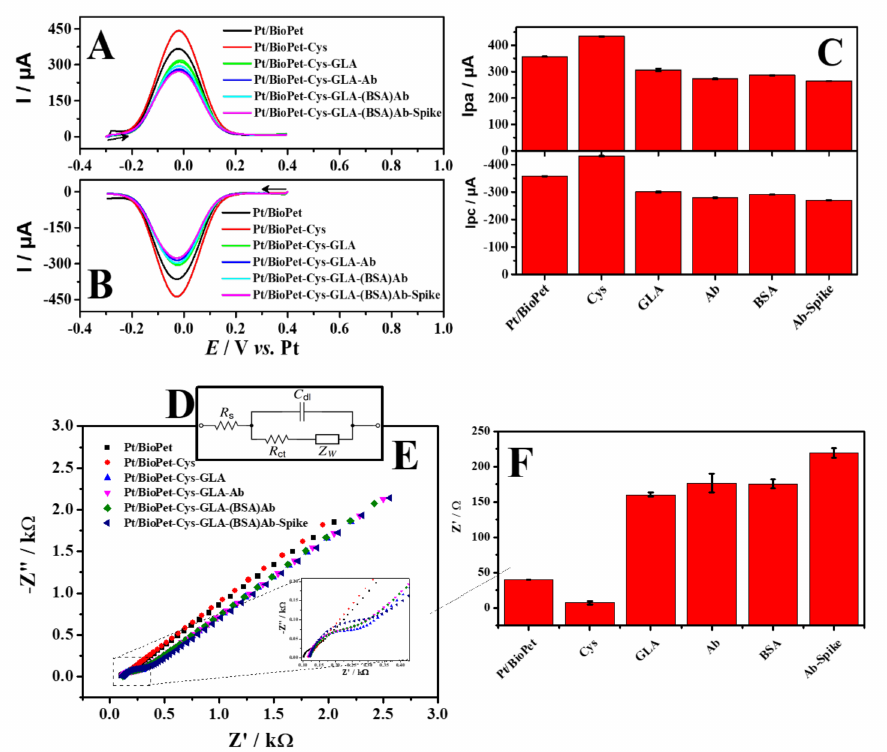
Figure 4. SWV voltammograms at ( A ) direct and ( B ) reverse. ( C ) Graph of peak current after each modification step, obtained from ( A , B ). ( D ) The equivalent circuit used for simulation of the experimental data, in the presence of redox couples: R ct , electron-transfer resistance; Rs, the resistance of the electrolyte solution; C dc , is the double-layer capacitance and; W, Warburg impedance. ( E ) Nyquist diagram ( F ) Graph of peak current after each modification step, obtained from ( D ). Platinum-printed electrode (Pt/BioPET), Pt/BioPET-cysteamine (Pt/BioPET-CYS), Pt/BioPET-CYS- glutaraldehyde (Pt/BioPET-CYS-GLA), Pt/BioPET-CYS-GLA-antibody (Pt/BioPET-CYS-GLA-Ab), Pt/BioPET-CYS-GLA-(BSA) antibody (Pt/BioPET-CYS-GLA-(BSA)Ab) and Pt/BioPET-CYS-GLA- (BSA) Ab-SARS-CoV-2 Spike Protein